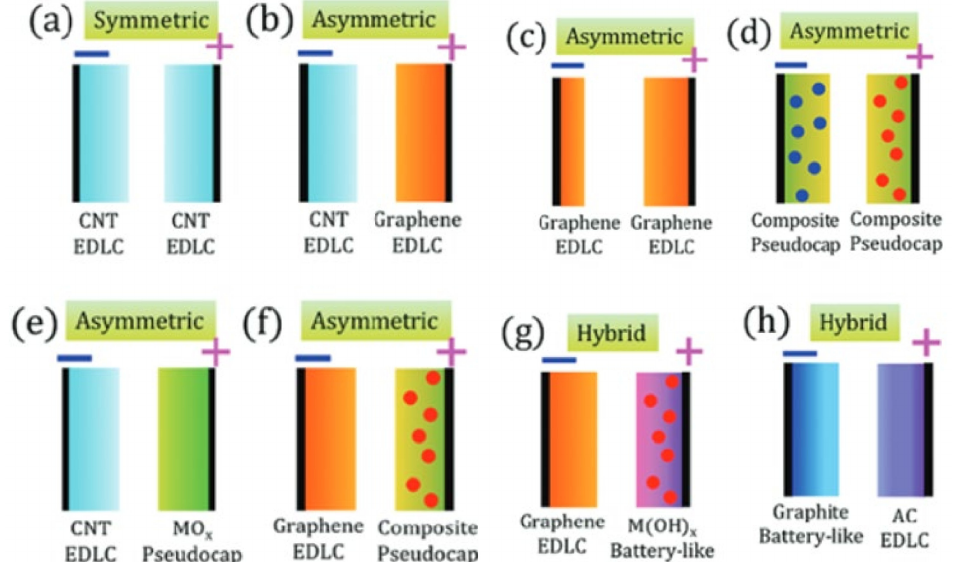
Figure 3. Schematic representation of the symmetric, asymmetric, and hybrid configurations. ( a ) Sym-